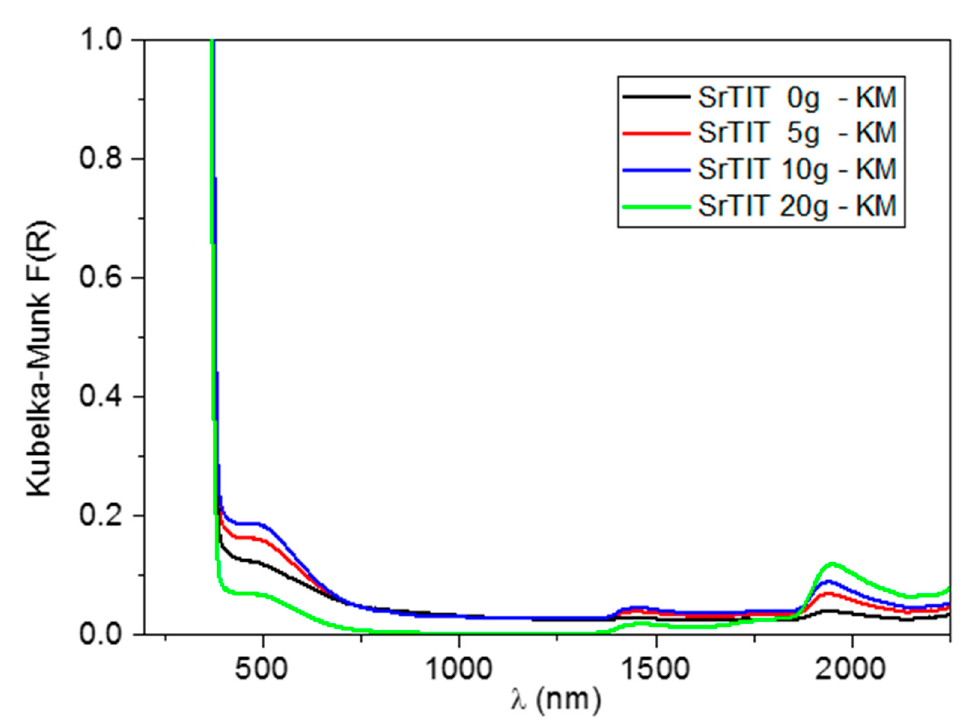
Figure 6. UV–vis–NIR diffuse reflectance spectra of the synthesized materials.